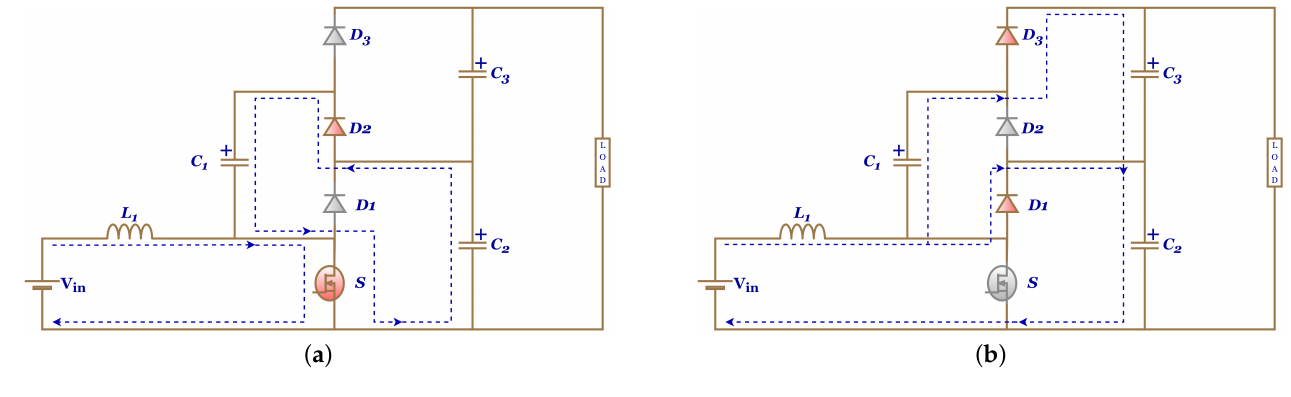
Figure 4. DBC operation: ( a ) S closed and ( b ) S